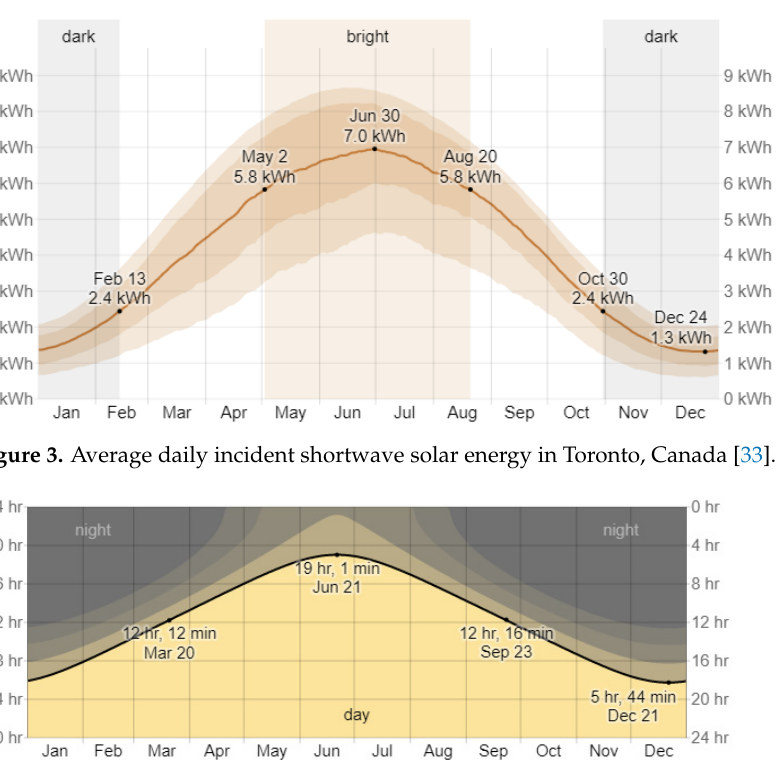
Figure 4. Hours of daylight and twilight in Bergen, Norway [34].